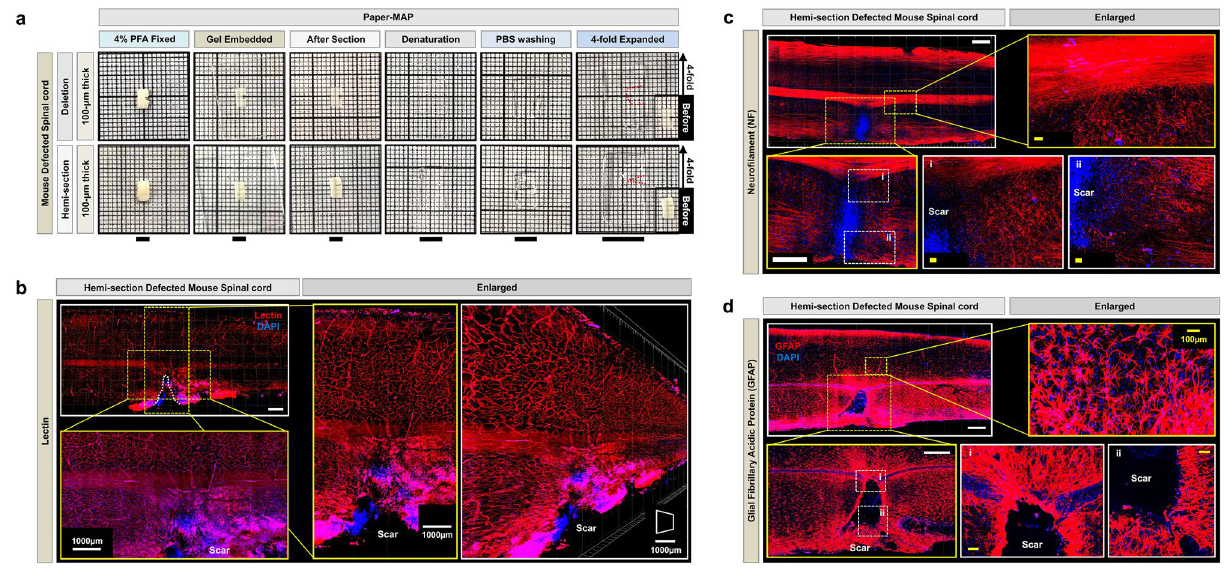
Figure 5. Paper-MAP processing of mouse spinal cord injury tissue. ( a ) Optical transparency of 100 μm-thick sections from mouse models of hemisection and deletion spinal cord injury models upon processing via Paper-MAP. Tissue transparency was assessed against a patterned background (length:width = 2 mm:2 mm). Representative images of samples from the hemisection spinal cord injury model processed via Paper-MAP and immunostained for lectin (red, range: 300-μm) ( b ), neurofilament (red) ( c ), and GFAP (red) ( d ). Yellow and white boxes indicate enlarged and 3D-projection images (range: 130-μm). Dotted white lines indicate scar region. Scale bars: white = 1000-μm, yellow = 100-μm. Illustration of mechanism is visualized by